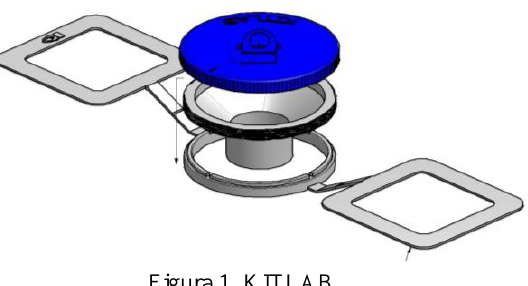
Figura 1. KITLAB.